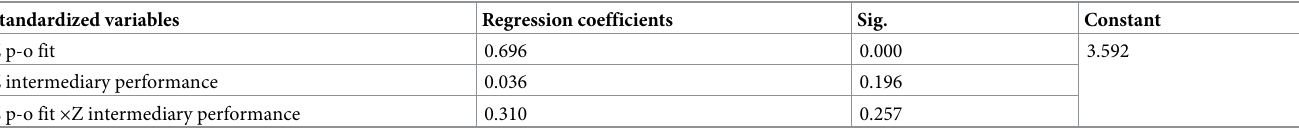
Table 4. Regression coefficients of P-O fit and intermediary performance (The dependent variable: alliances performance). Standardized variables